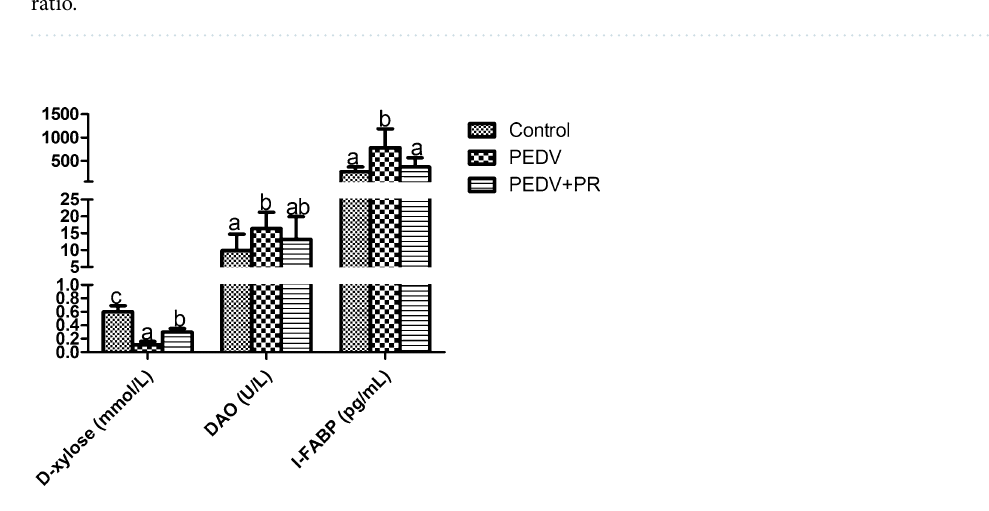
Figure 2. Effects of puerarin (PR) administration on blood DAO activity and D-xylose, I-FABP concentrations of piglets after PEDV infection. Values are mean and SD, n = 8. a, b, c , Values within a column not sharing a common superscript letter indicate significant difference at P <